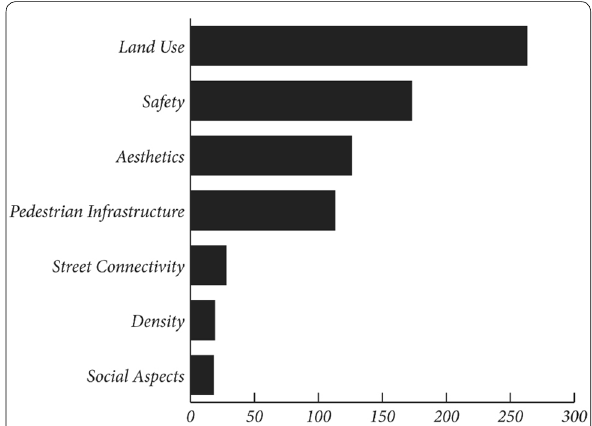
Fig. 7 Results of the open-ended surveys using cue cards (n approx.). The most relevant and spoken about attributes influencing walkability in the neighborhoods of